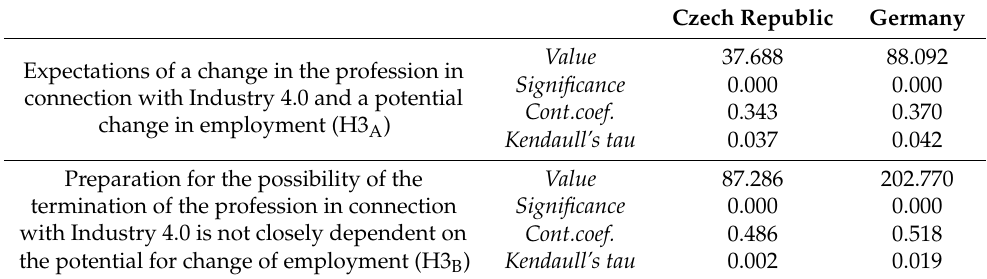
Table 3. Gained results for sub-hypotheses